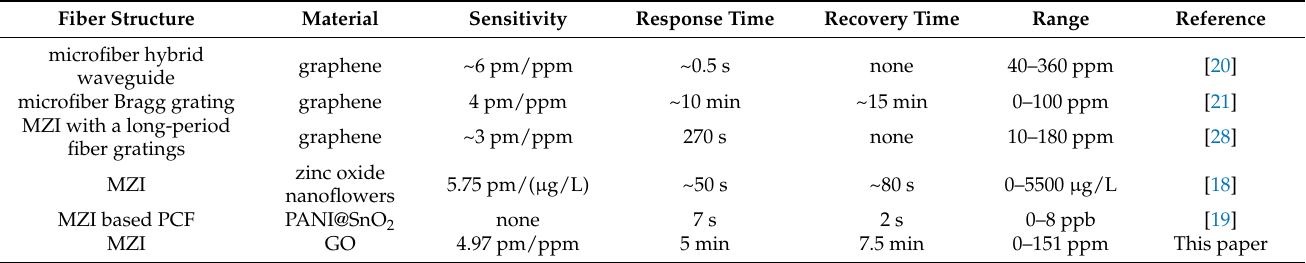
Table 1. Performances of optical fiber humidity sensors proposed in different literatures.